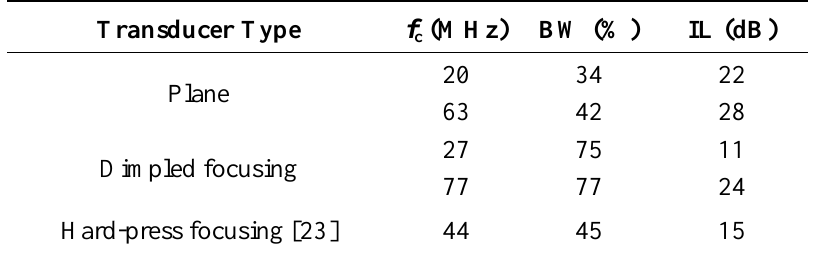
Table 2. Summary of the plane and focusing PMN-PT transducer performance